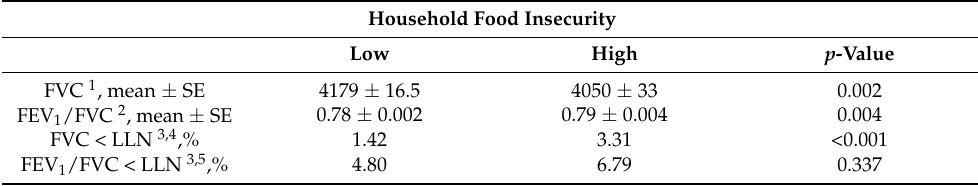
Table 2. Differences between respiratory outcomes across food insecurity at household level.